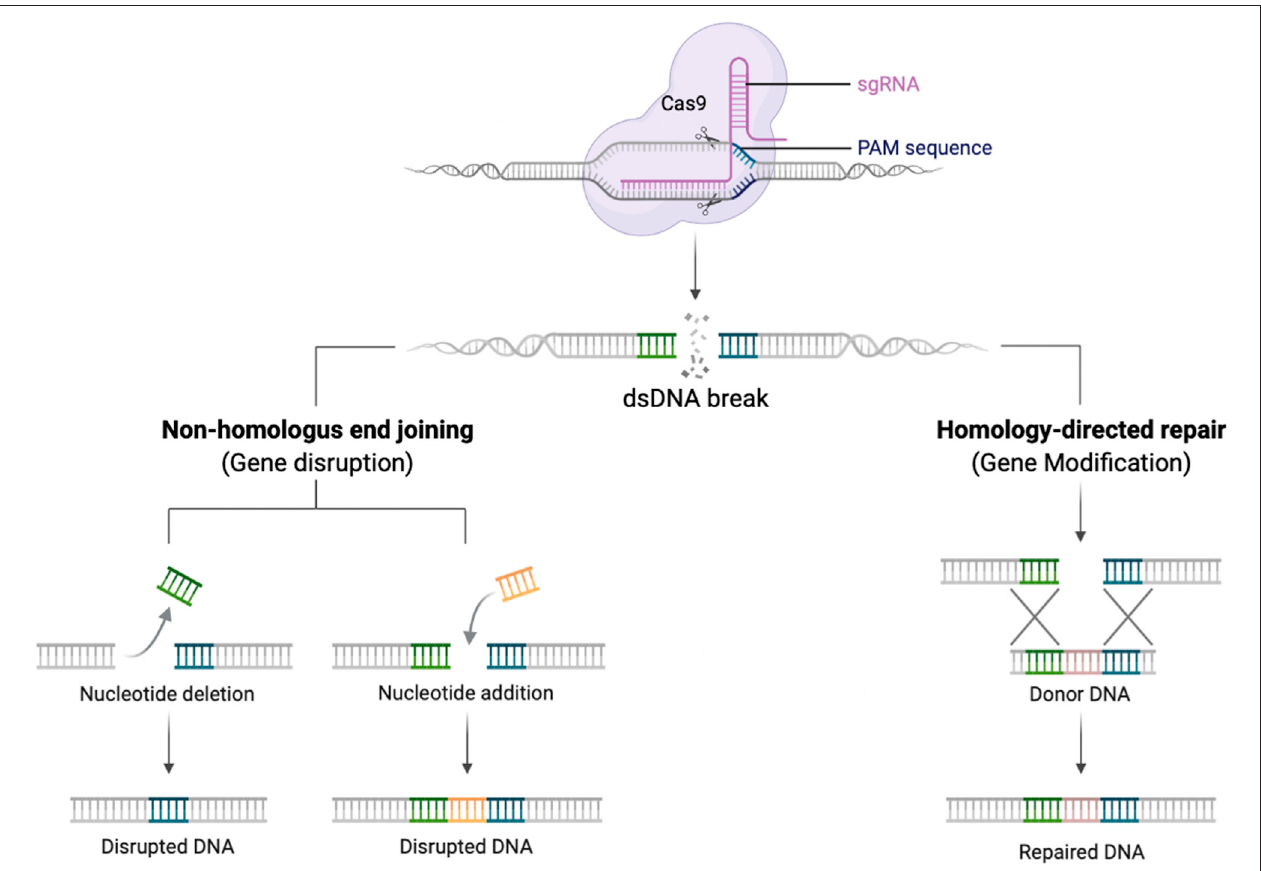
FIGURE 1 | Schematic diagram demonstrating the gRNA/Cas9 complex performing a dsDNA break. Once the dsDNA break is created, the DNA repairs itself by NHEJ creating insertions and deletions (left pathway), or in the presence of a donor DNA template HDR can occur with insertion of new genetic material (right pathway). Created with biorender.com.